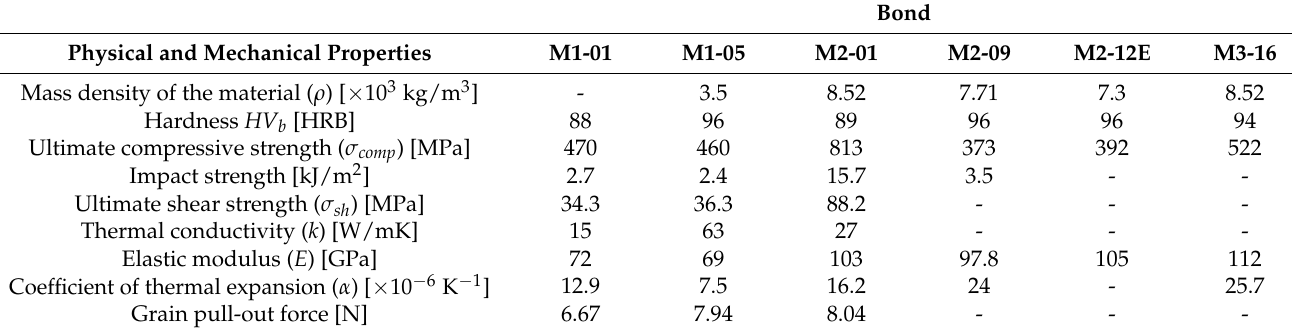
Table 1. Material composition of bond types used in the models.